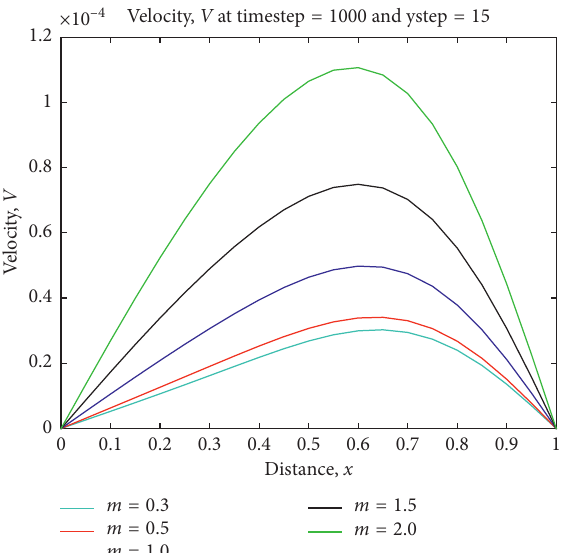
Figure 3: Graph of effects of the magnetic parameter on secondary velocity profile v